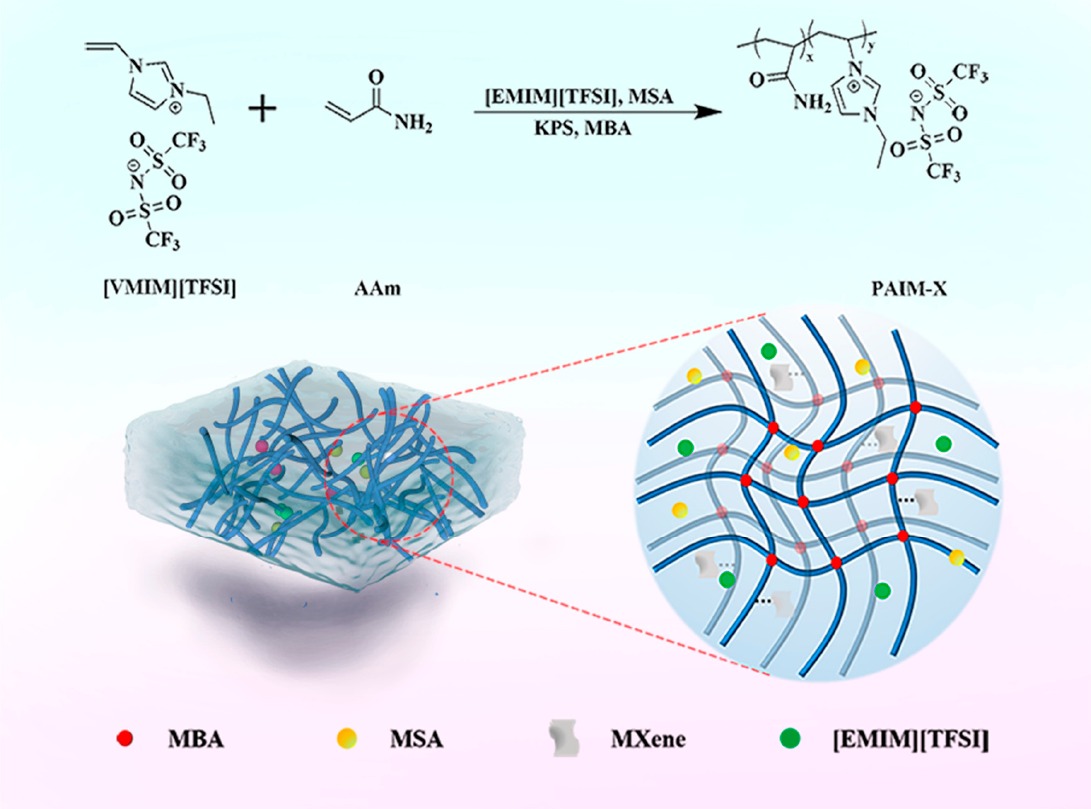
Figure 7. Synthesis and formation mechanism of PAIM-X ionogel.